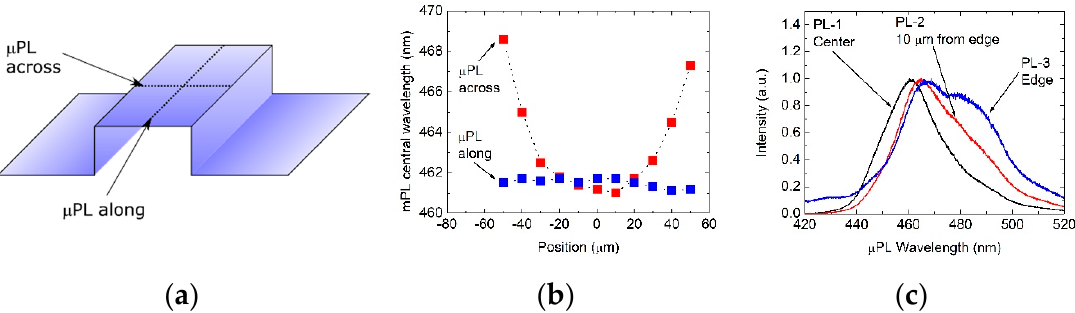
Figure 4. µ PL of the InGaN / GaN structure. Stripe width 100 µ m, stripe height 4 µ m. ( a ) Measurement scheme with two scan lines across and along the stripe. ( b ) Wavelength across and along the stripe. ( c ) Spectra acquired at stripe center, 10 µ m from stripe edge, and at the stripe edge.